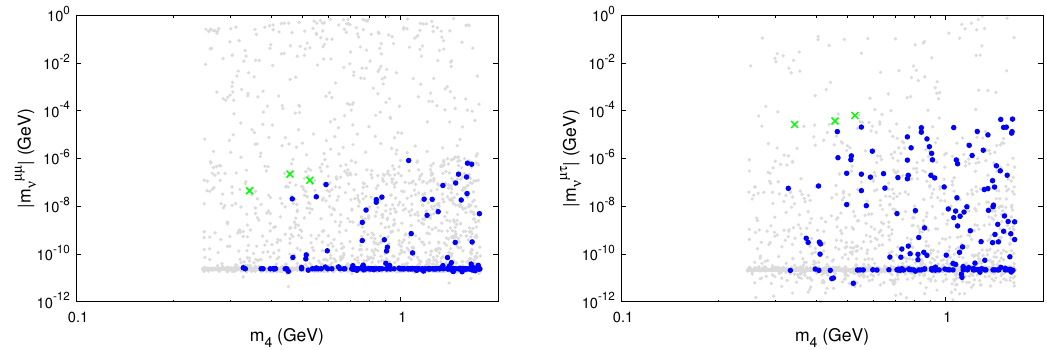
Figure 18 . Predictions for the e(cid:11)ective mass m (cid:11)(cid:12) fermion mass, m 4 , derived from the LNV D ! (cid:22)(cid:22)(cid:25) and (cid:28) ! (cid:22)(cid:25)(cid:25) decay modes. Colour code as in (cid:12)gure